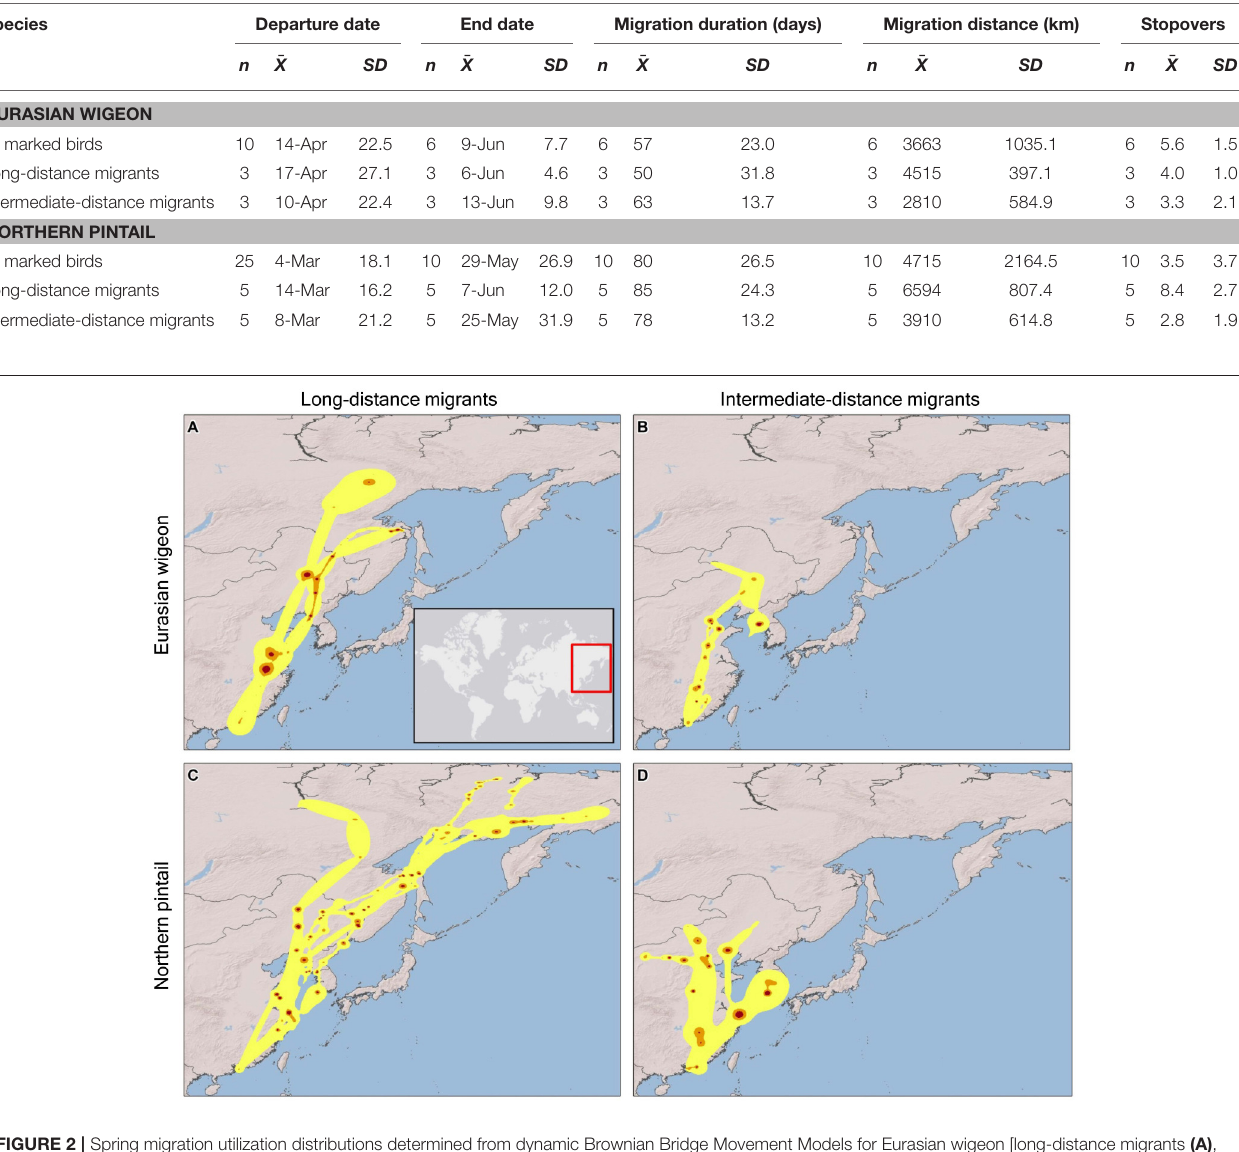
Frontiers in Ecology and Evolution |